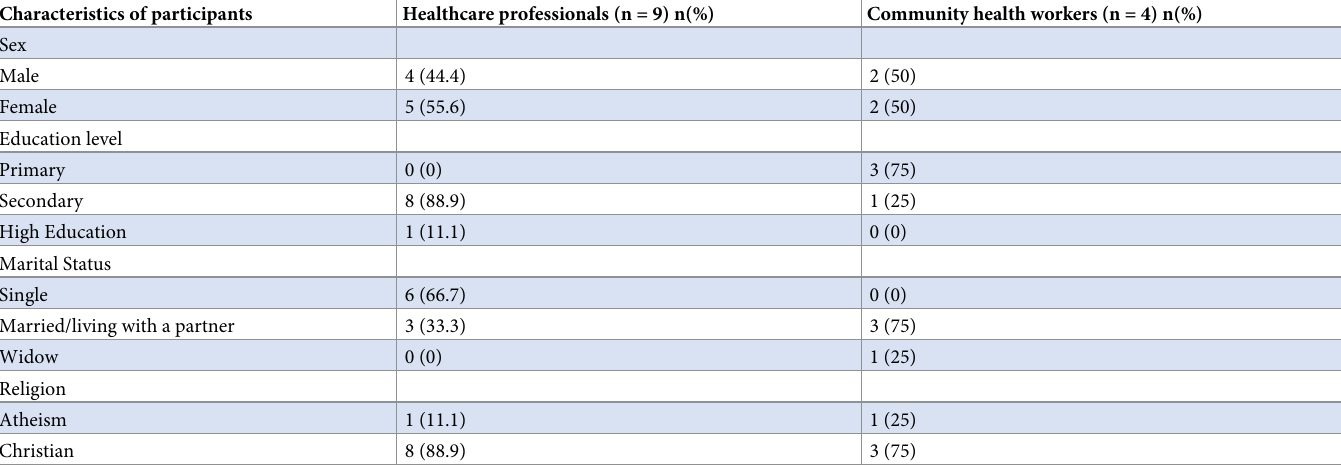
Table 4. Sociodemographic characteristics of healthcare professionals and community health workers. Characteristics of